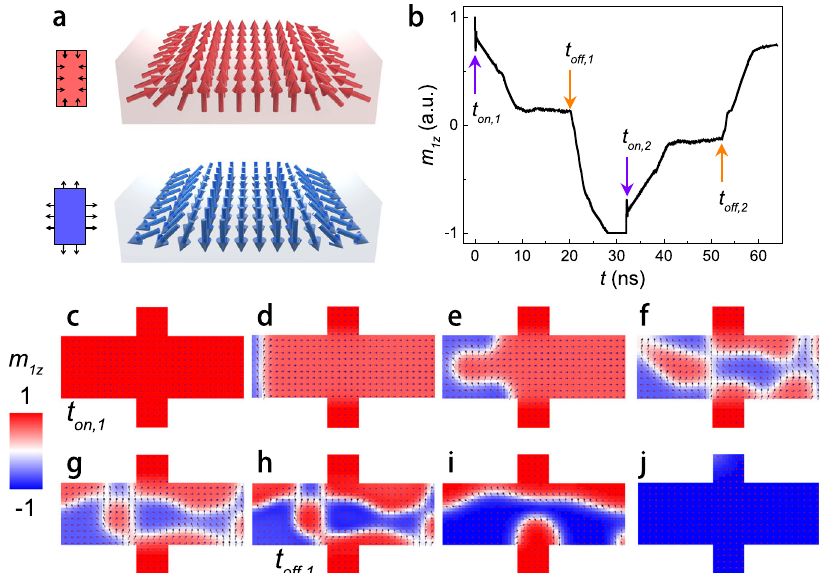
Fig. 5 Micromagnetic simulations. a A sketch of the magnetization tilting driven by DMI boundary conditions allowing domain nucleation at the edges. b Average z component of the fi rst sublattice magnetization in the switching of the system from 0 ns to 32 ns, and from 32 ns to 64 ns, respectively (under opposite current directions). c – j First sublattice magnetization distribution at different times of the dynamics (0 – 32